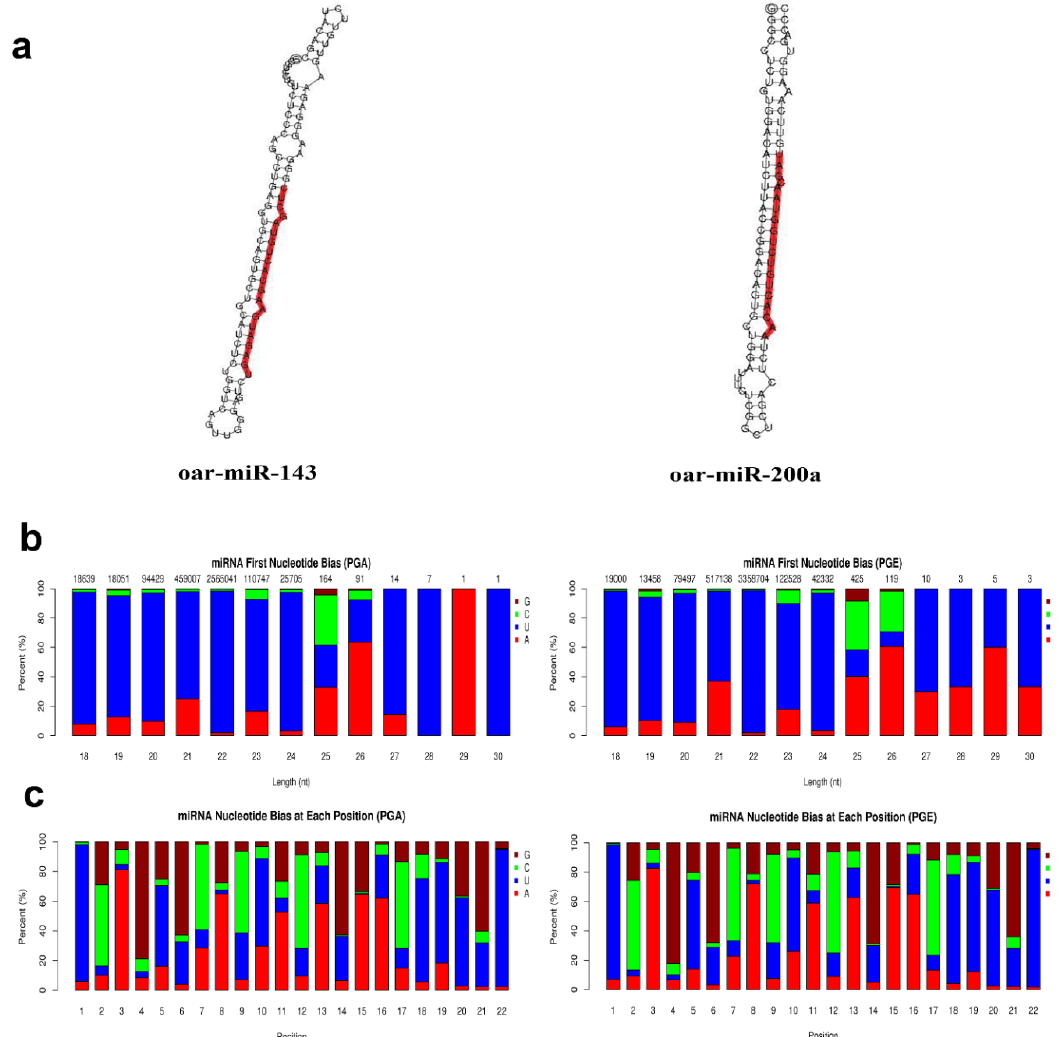
Figure 3. Analysis of known miRNAs. ( a ) Secondary structure of known miRNAs. The whole sequence is a precursor miRNA and the red highlight is mature sequence. ( b ) First base preference of known miRNAs of 18 to 30 nucleotides (nt) in length (the horizontal axis is the length of the miRNA and the vertical axis is the ratio of A / U / C / G in the first base of the miRNA in length). ( c ) Base distribution of known 22 nt miRNAs (horizontal axis is miRNA base position and the vertical axis is the ratio of bases A / U / C / G of the miRNA at this position).